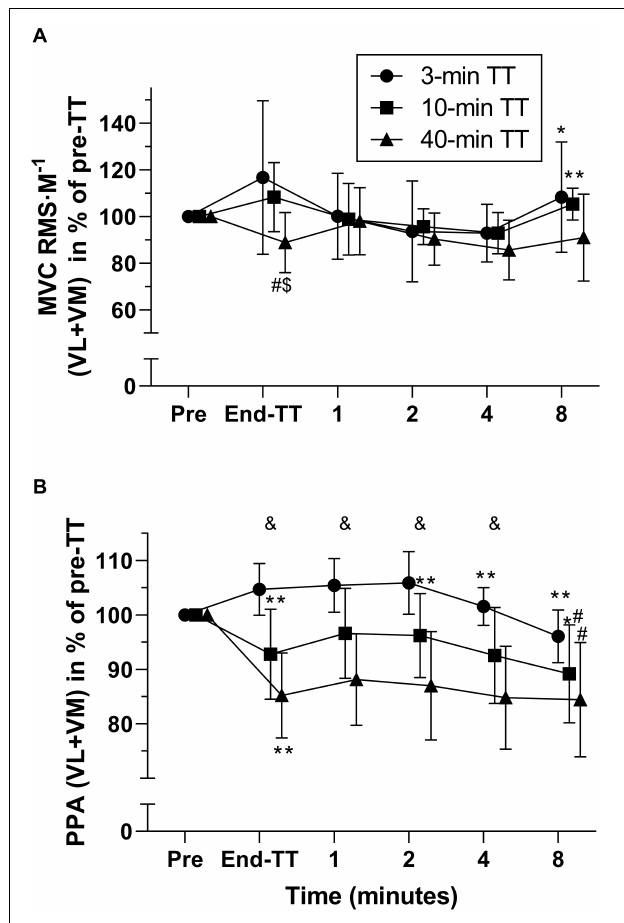
FIGURE 4 | Electromyography (EMG) responses during recovery, expressed as % of pre-TT for 3, 10, and 40 min duration TTs. MVC RMS normalized to M-wave amplitude (average vastus lateralis and vastus medialis (A) . M-wave peak-to-peak amplitude (average vastus lateralis and vastus medialis) expressed as % of pre-TT (B) . Data are shown as means ± SD, n = 11. MVC, maximal voluntary contraction; RMS, root mean square; M, M wave; PPA, peak-to-peak amplitude; VL, vastus lateralis; VM, vastus medialis. *Different from previous. # Different from 3-min TT. & All three TTs are different from each other at this time point. The number of symbols indicate significance at * P < 0.05 and ** P < 0.01.